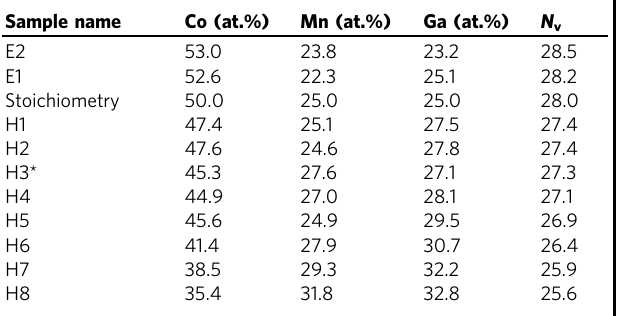
Results of the composition analysis using XRF and estimated valence electron number ( N v ) for all 10 Co 2 MnGa fi lms prepared. The stoichiometric composition ( N v = 28.0) is also shown as a